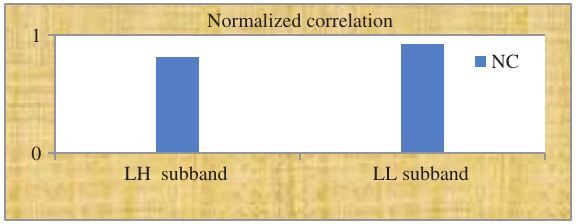
Figure 6: Comparative Analysis of Decoder Performance of Algorithms 1 and